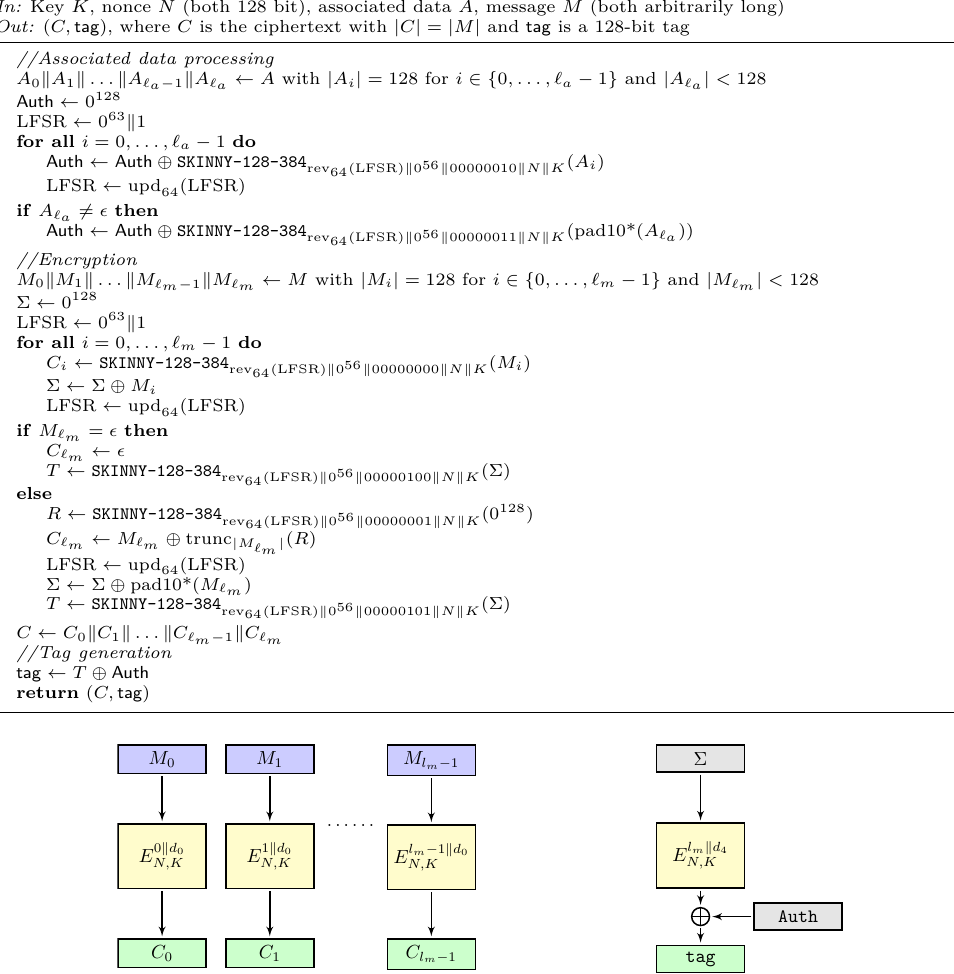
Algorithm 1 The authenticated encryption algorithm SKINNY - AEAD - M1 - Enc ( K,N,A,M ) In: Key K , nonce N (both 128 bit), associated data A , message M (both arbitrarily long) Out: ( C, tag ), where C is the ciphertext with | C | = | M | and tag is a 128-bit tag //Associated data processing A 0 k A 1 k ... k A ‘a − 1 k A ‘a ← A with | A i | = 128 for i ∈ { 0 ,...,‘ a − 1 } and | A ‘a | < 128 Auth ← 0 128